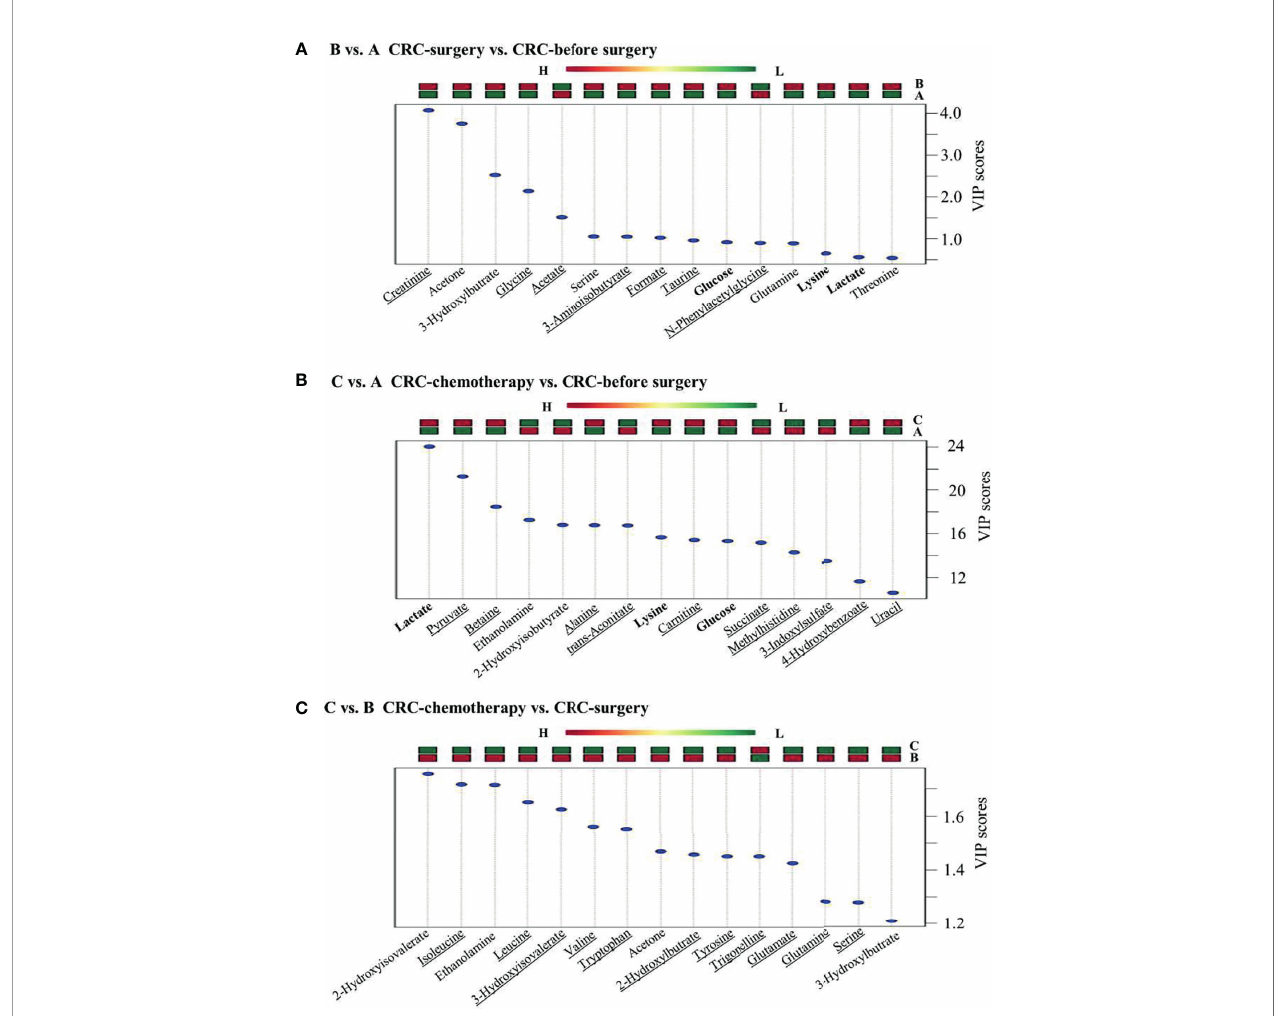
FIGURE 5 | Group comparisons between the two groups alone with CRC clinical treatment. (A) CRC patients before surgery versus healthy controls, (B) CRC patients after surgery versus before surgery, and (C) CRC patients after chemotherapy versus after